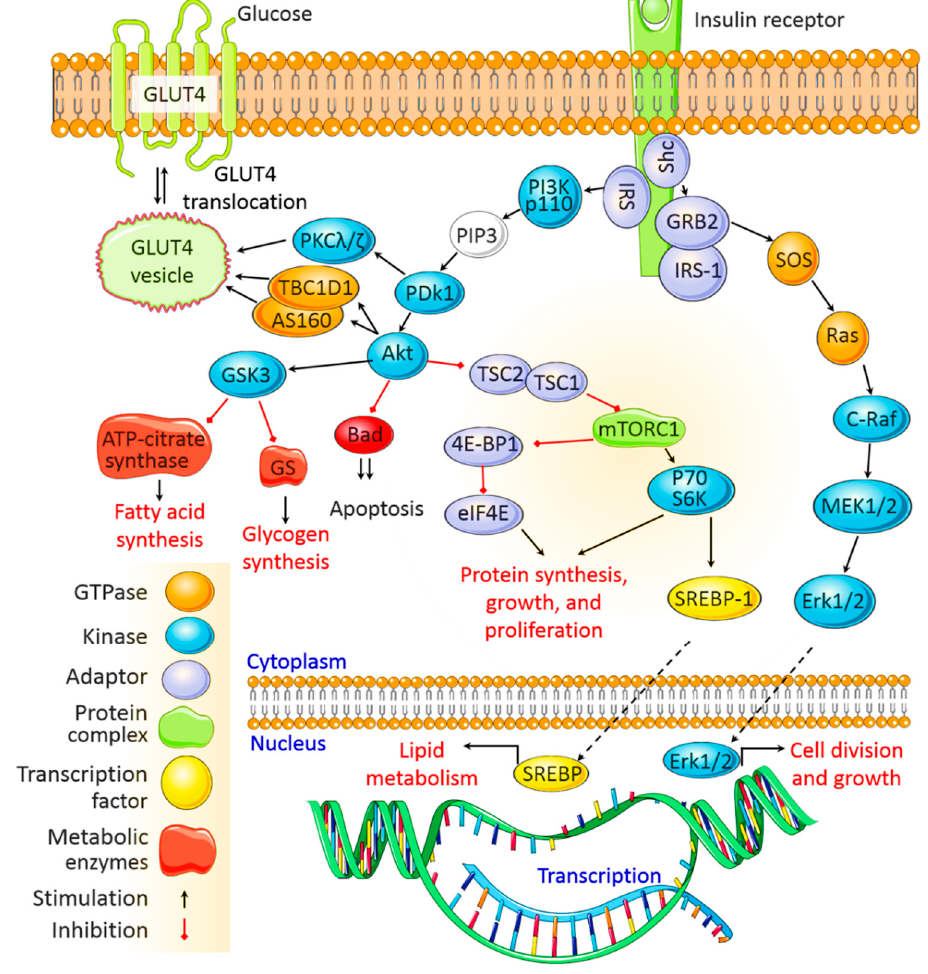
Figure 1. Classic insulin signaling pathway. Insulin regulates cellular functions and metabolic activity by binding to the insulin receptor. Core cellular processes downstream of the insulin signaling system include the PI3K/Akt and MAPK signaling pathways; details on these pathways are given in Section 3. IRS, insulin receptor substrate; IR, insulin receptor; PI3K, phosphoinositide3 ‐ kinase; MAPK, mitogen ‐ activated protein kinase; PIP3, phosphatidylinositol 3,4,5 ‐ triphosphate; PDK1, 3 ‐ phosphoinositide dependent protein kinase ‐ 1; Grb2, growth factor receptor ‐ bound protein 2; GSK, glycogen synthase kinase; GS, glycogen synthase; mTORC1, mammalian target of rapamycin complex 1; SREBP, sterol regulatory element ‐ binding protein; glucose transporter 4, GLUT4; MEK, MAPK/Erk kinase; ERK, extracellular signal ‐ regulated kinase.